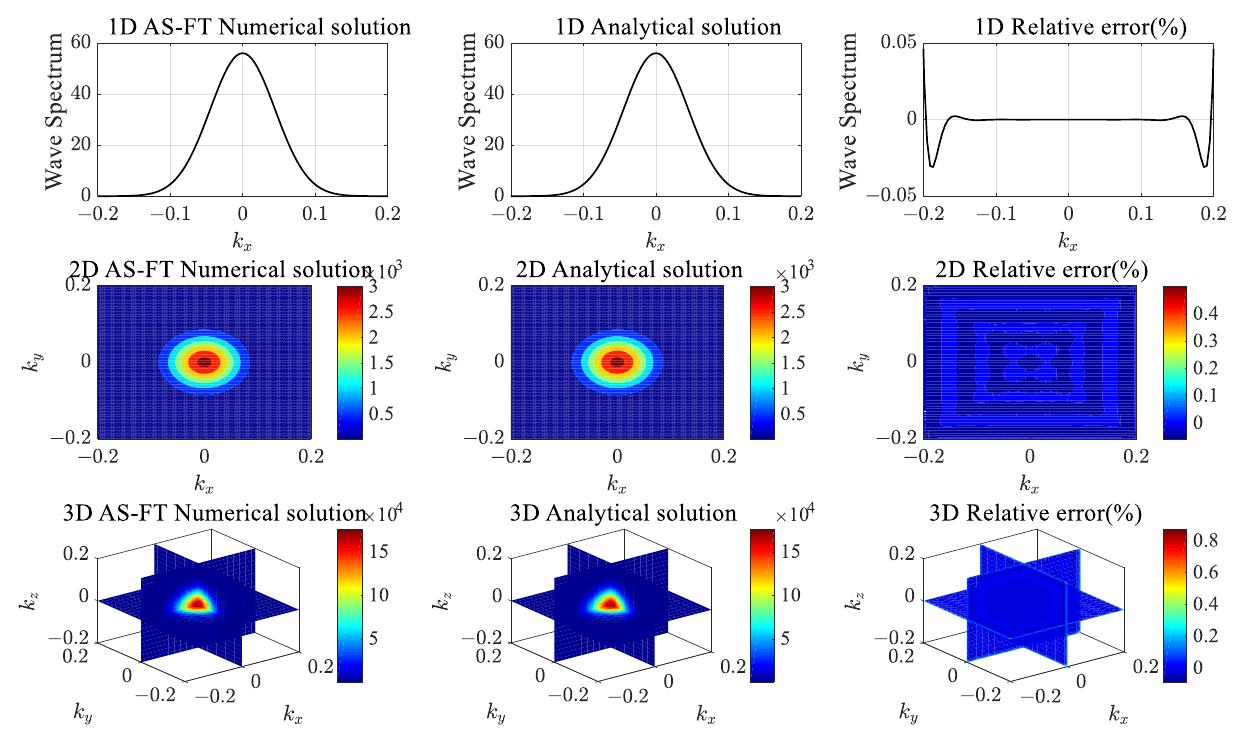
Figure 2. The numerical solution, analytical solution, and relative error of the forward transform.